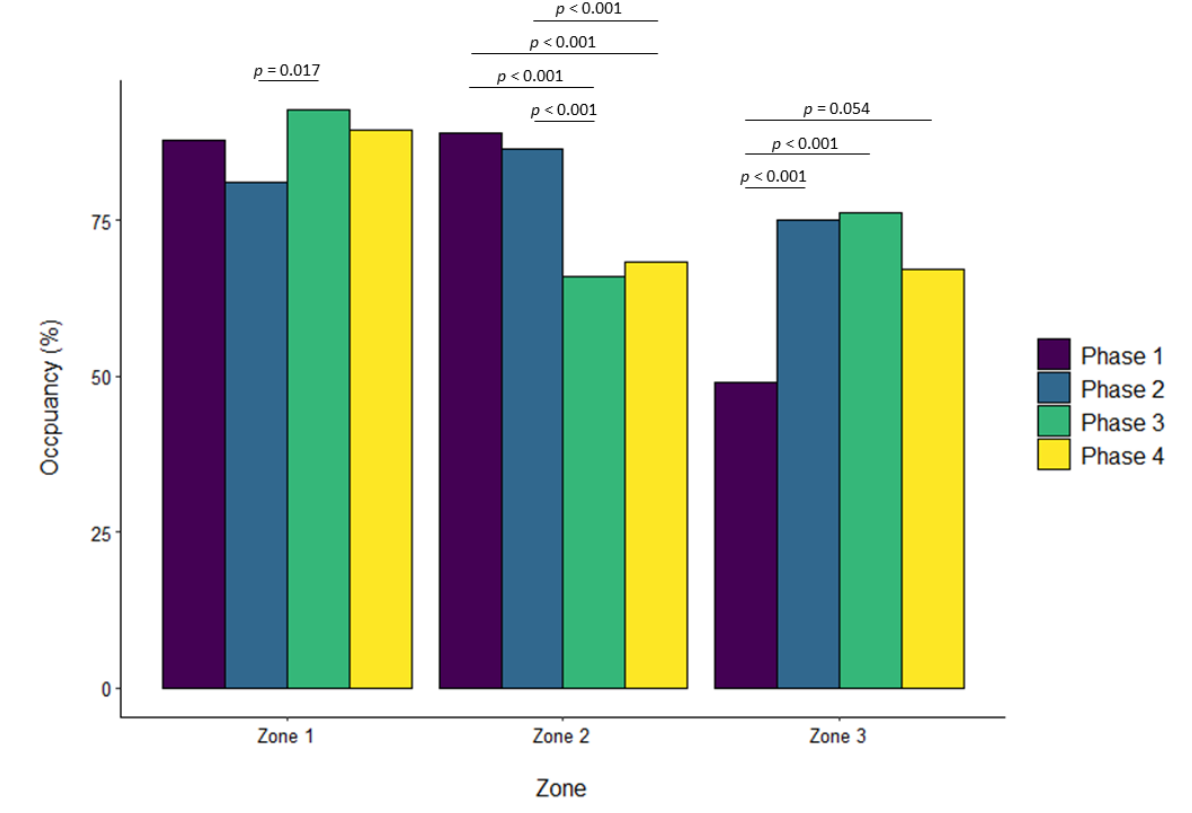
Figure 11. Percent occupancy of each zone by phase for the western lowland gorillas.